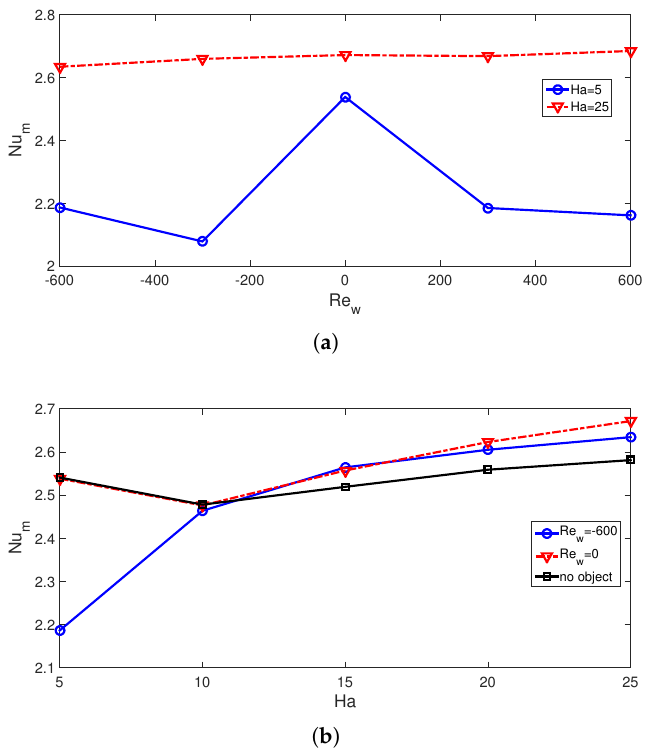
Figure 8. Average Nu variations with respect to changes in ( a ) Rew and ( b ) MaF strength (Da = 5 × 10 − 2 ,Mx = − 1,AR =